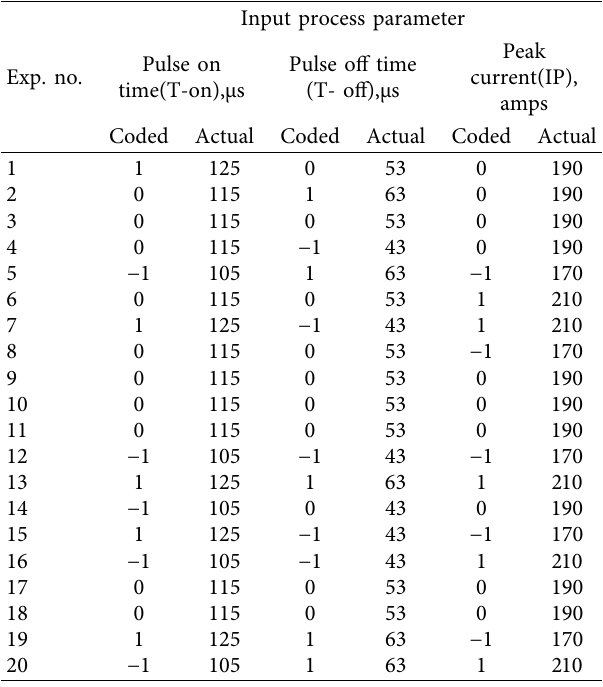
Table 10: Coefficients of estimated regression for material removal rate (MRR).